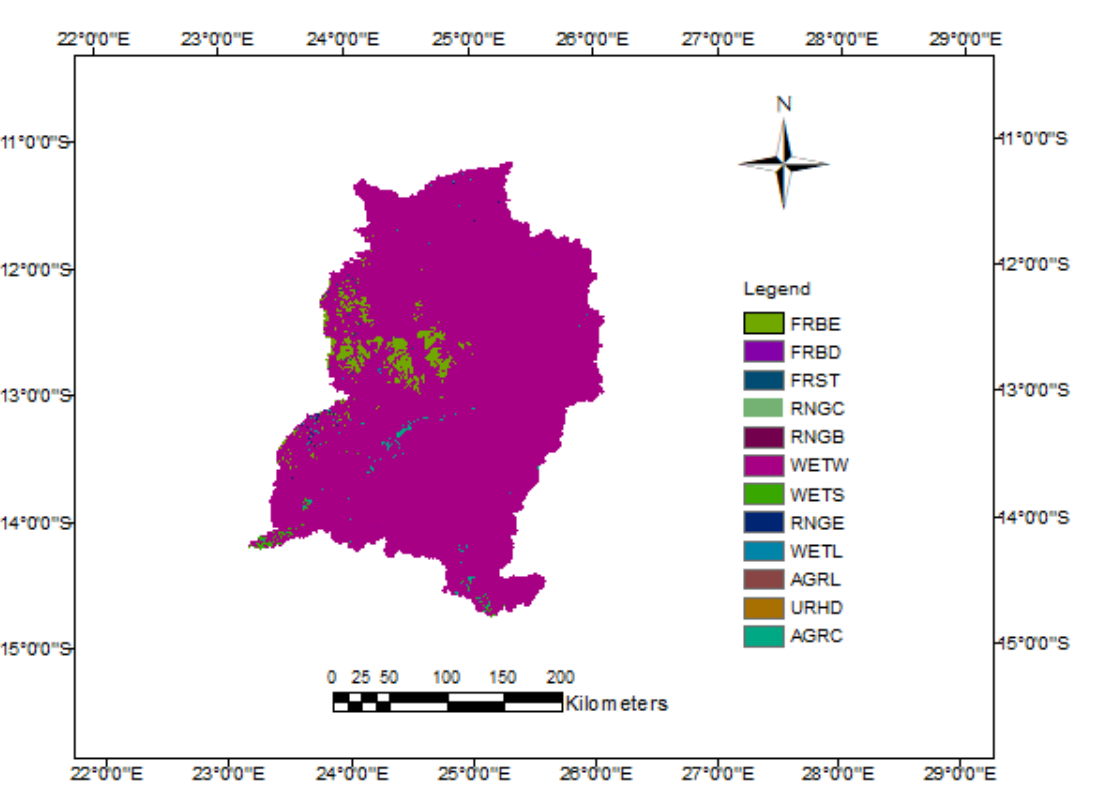
Figure 8. Land use/land cover for Kabompo catchment [21].